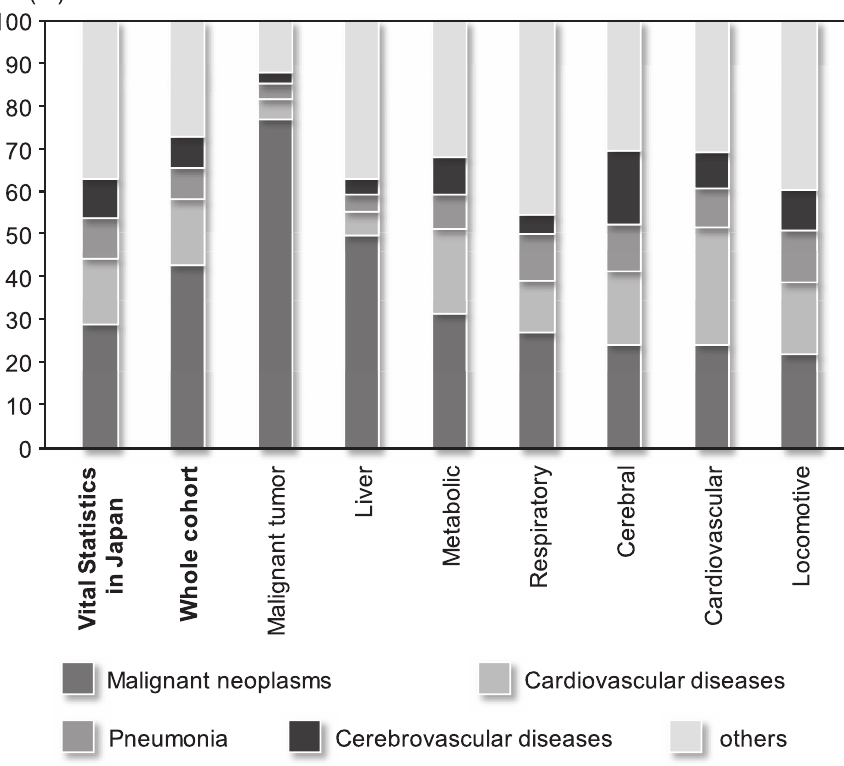
Fig. 3. Distribution of underlying cause of death in all subjects and disease categories. Each bar represents the distribution of underlying cause of death, categorized byICD10 in all subjects or each disease category; malignant neoplasms were coded by C00-C97, cardiovascular diseases (other than hypertension) I01-I02, I05-I09, I20-I25, I27 and I30-I52, pneumonia J12-J18, cerebrovascular diseases I60-69. This categorization was based on Vital statistics ( fi rst from left), Japan in 2014, published by Ministry of Health Labour and Welfare,